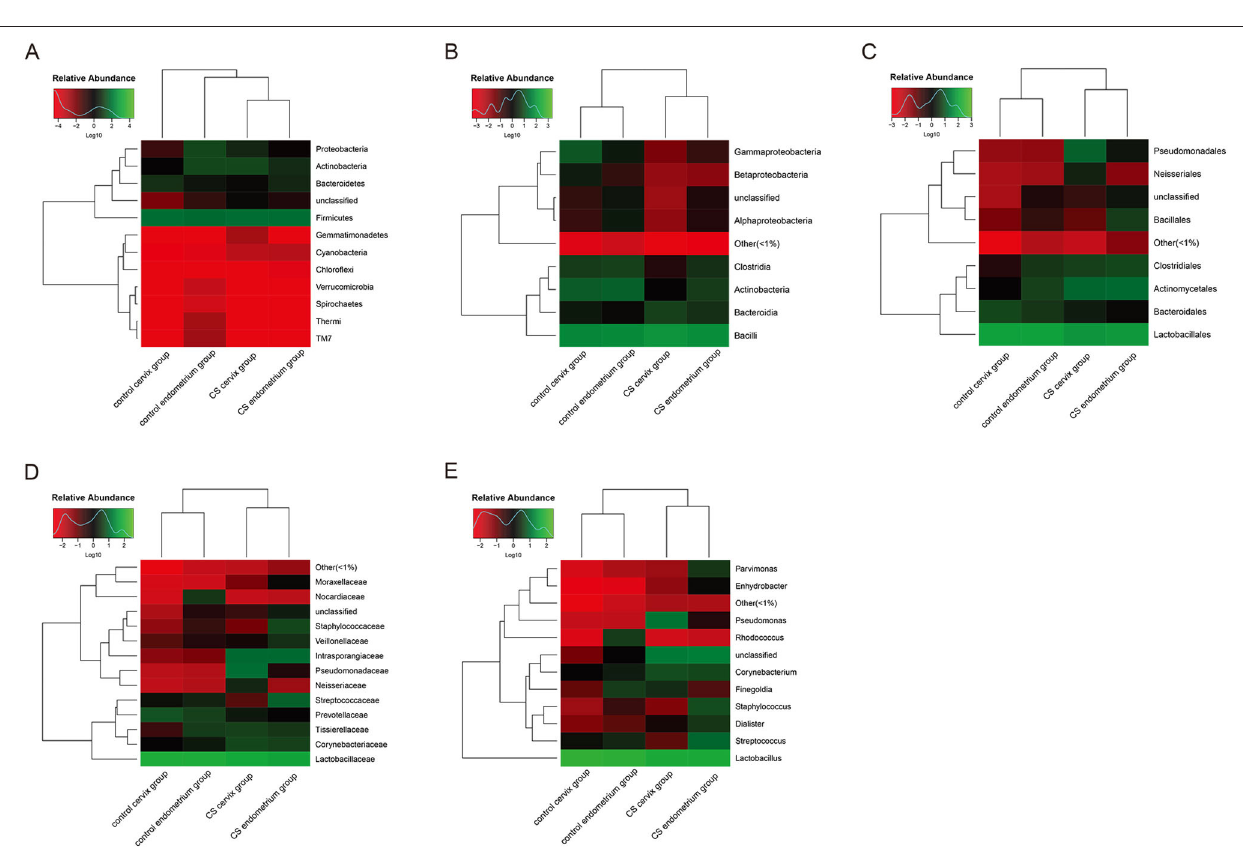
FIGURE 3 | Heatmaps for the clustering analysis. (A) Heatmap at the phylum level; (B) heatmap at the class level; (C) heatmap at the order level; (D) heatmap at the family level; (E) heatmap at the genus level. The color scale bar ranged from − 2.0 to 2.0, with green, black, and red representing the low (green), medium (black), and high (red) microbial abundance,